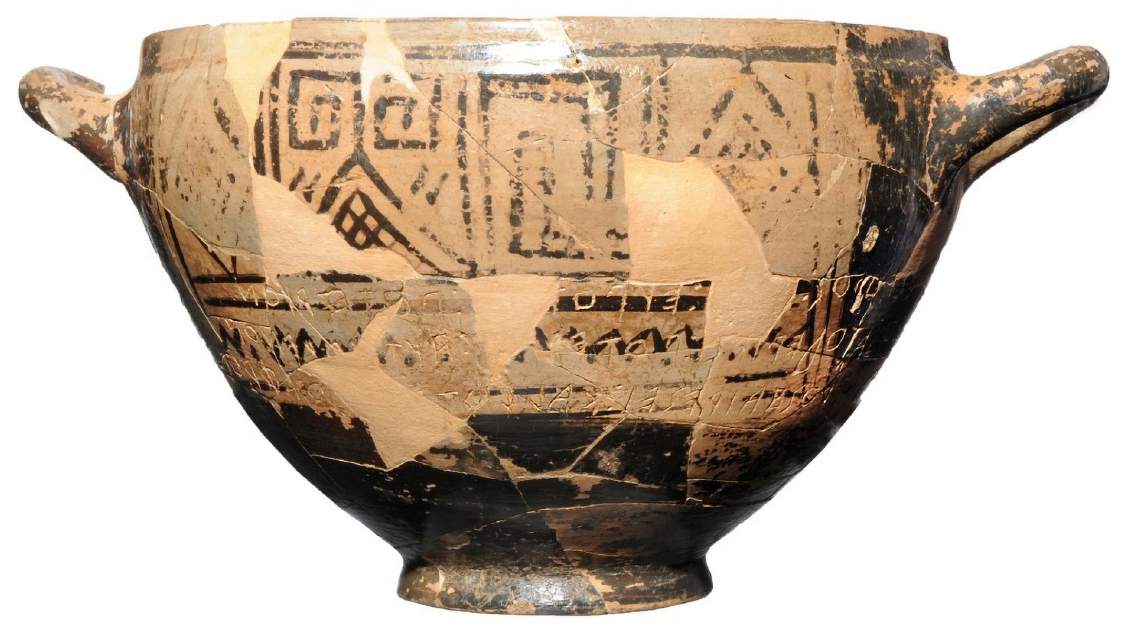
Fig 3. Nestor’s Cup from Cremation 168, Pithekoussai’s necropolis. The Cup is on permanent display at the Museo Archeologico Nazionale di Villa Arbusto, Lacco Ameno (Ischia Island). The metric inscription, partially in hexameter verses, translates roughly to ’ I am Nestor’s cup , good to drink from . Whoever drinks this cup empty , straightaway desire for beautiful-crowned Aphrodite will seize him ’ (picture from Soprintendenza Archeologia , Belle Arti e Paesaggio per l ’ area metropolitana di Napoli